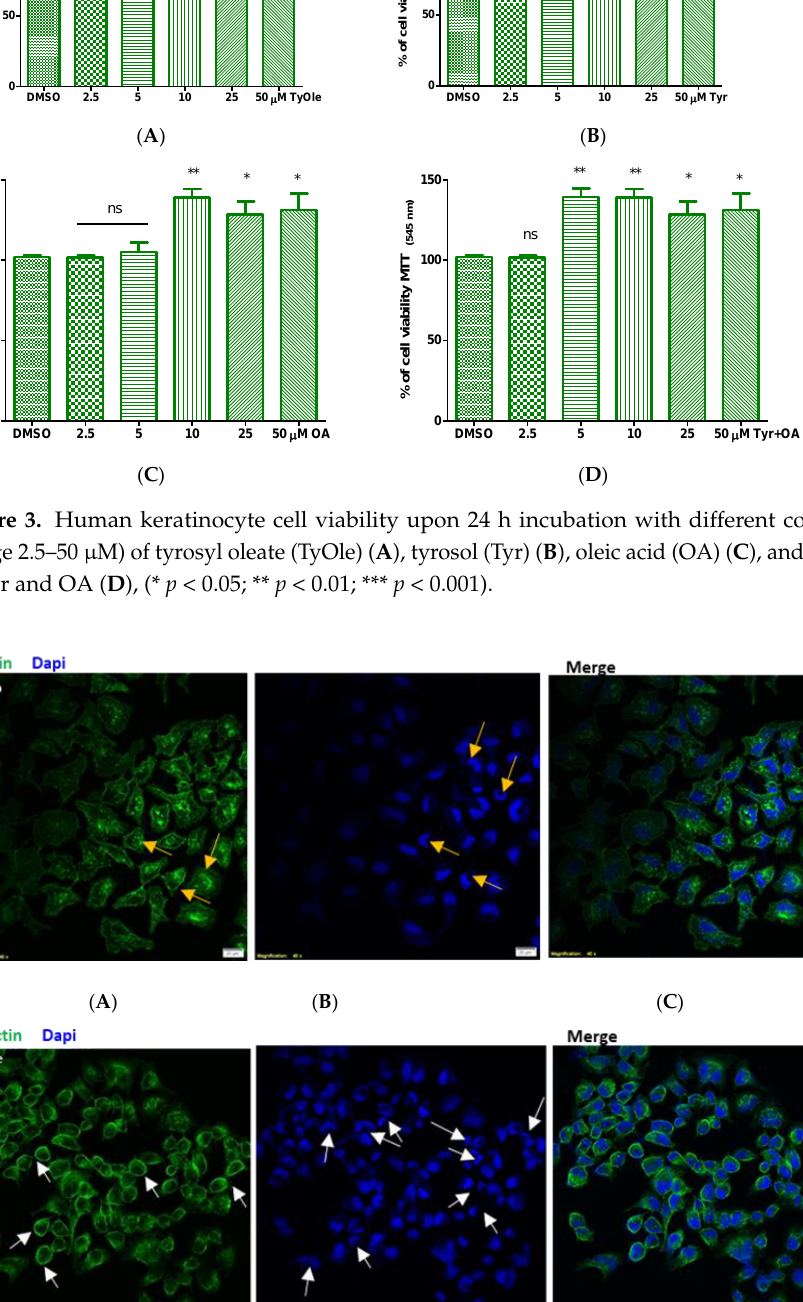
Figure 4. Cytoskeleton remodeling and nuclear lobe formation upon tyrosyl oleate (TyOle) treatment.